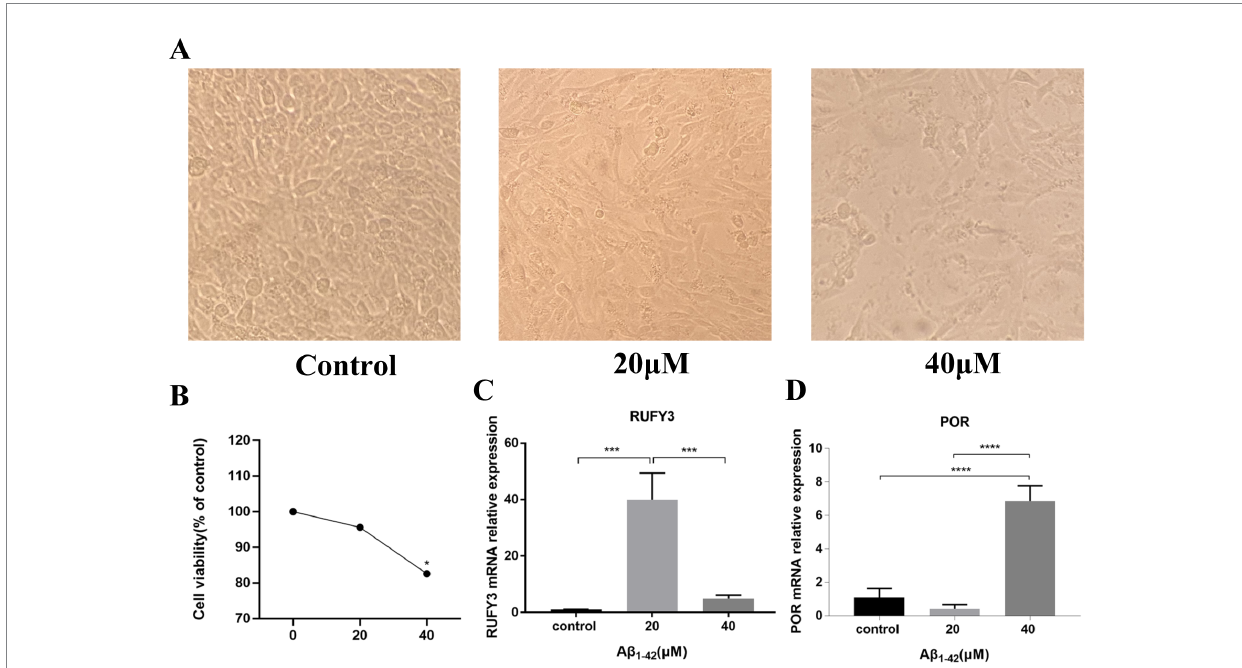
FIGURE 5 A β 1–42 interfered with PC-12 cells to verify the expression of representative genes selected by differential analysis. (A) The differences among the three groups of cells were observed under the electron microscope. (B) CCK-8 experiment verified the survival of cells under the condition of A β 1–42 in three concentration groups of 0, 20, and 40 μ M. (C) Expression of the representative up-regulated gene RUFY3 under the condition of A β 1–42 in three concentration groups of 0, 20, and 40 μ M. (D) Expression of the representative down-regulated gene POR under the condition of A β 1–42 in three concentration groups of 0, 20, and 40 μ M. * p < 0.05, *** p < 0.001, **** p <